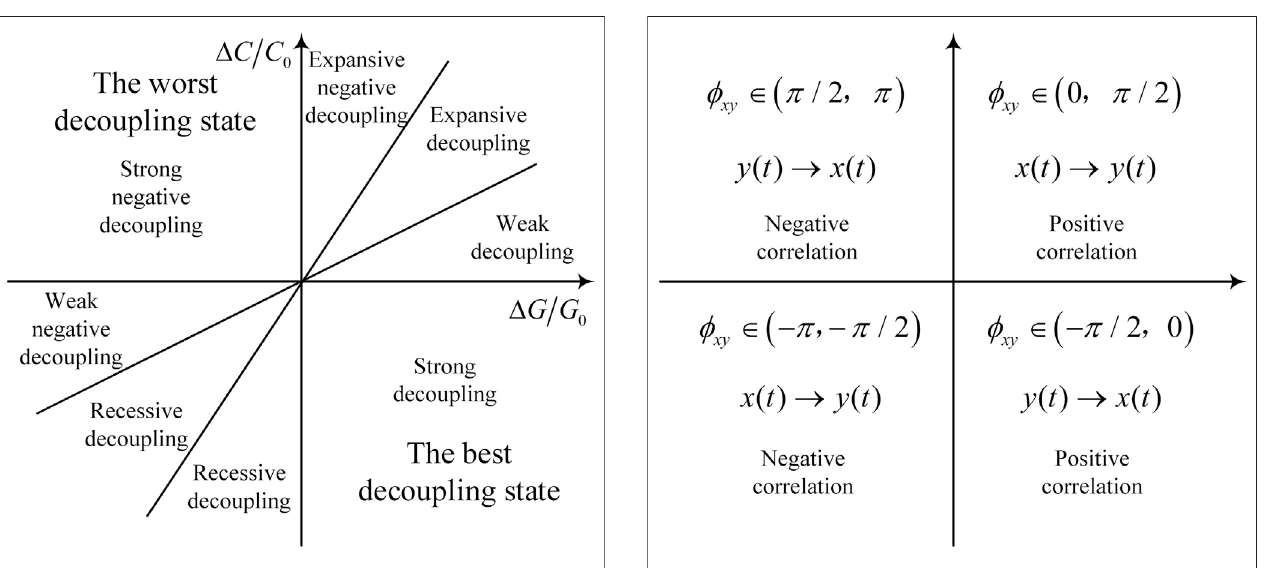
FIGURE 1 | chematic diagram of decoupling